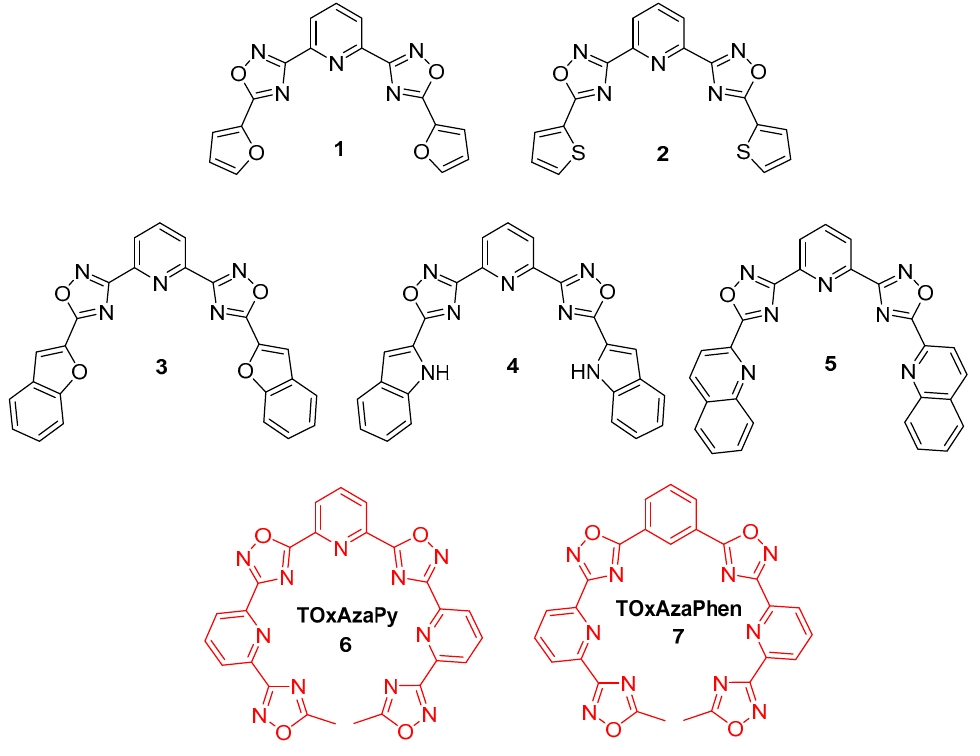
Figure 2. Structures of the newly synthesized non-macrocyclic penta-hetero-aromatics 1 – 5 and hepta- hetero-aromatics TOxAzaPy ( 6 ) and TOxAzaPhen ( 7 ). hepta-hetero-aromatics TOxAzaPy ( 6 ) and TOxAzaPhen ( 7